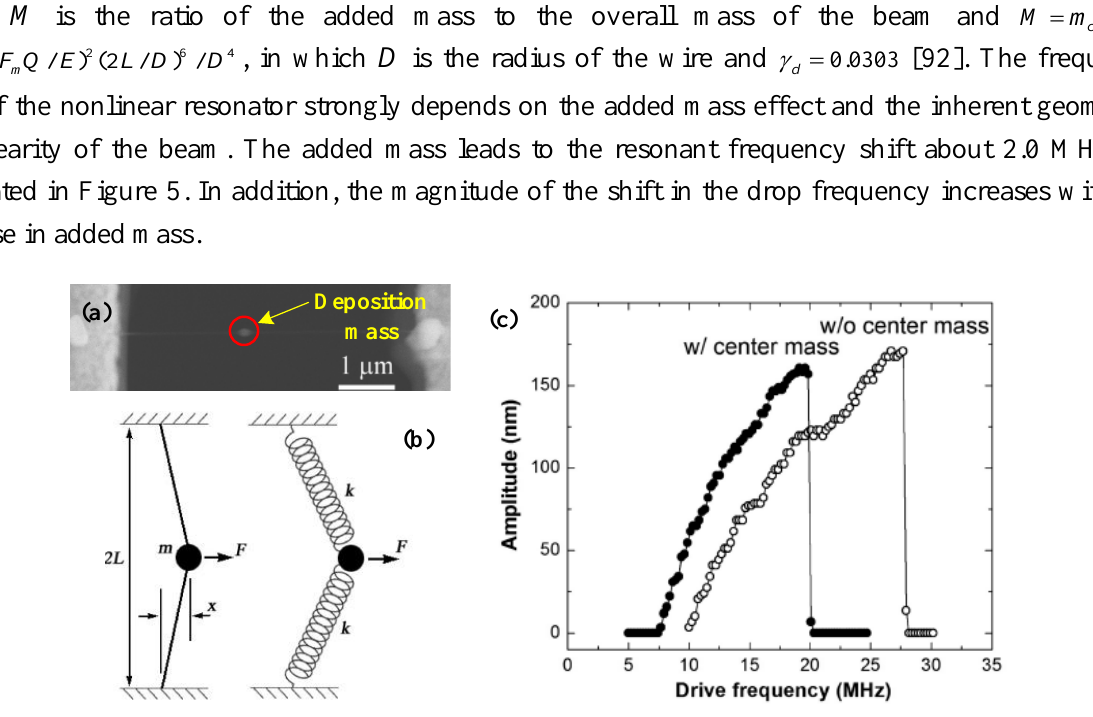
Figure 5. Dynamic response of the CNT nonlinear nanomechanical resonator with the added mass effect reported by Cho et al . [92]. ( a ) SEM image of the Pt deposit in the middle of a suspended CNT resonator; ( b ) Schematic diagram of a simple doubly clamped mechanical beam model with the intrinsic geometric nonlinearity; ( c ) The dynamic response of the resonator without and with depositing a center mass with electron-beam-induced deposition. Reused with permission from [92], Copyright 2010, American Chemical